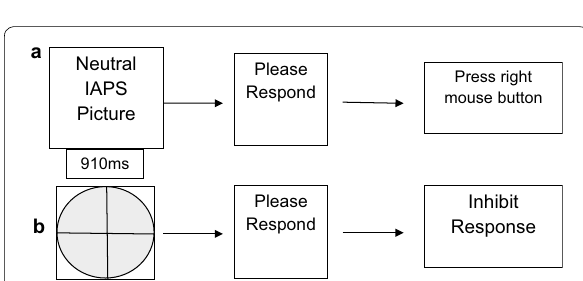
Fig. 2 Practice phase. a If the participant is presented with the target stimulus (in the example above, the target stimulus is a neutral IAPS picture), the participant will judge if the stimulus is shorter or longer than the standard duration. In the example above, the participant should press the right button on the mouse to indicate that the duration was longer than the standard stimulus duration. b If the participant is presented with the nontarget stimulus (the gray oval used in the learning phase), the participant will inhibit any